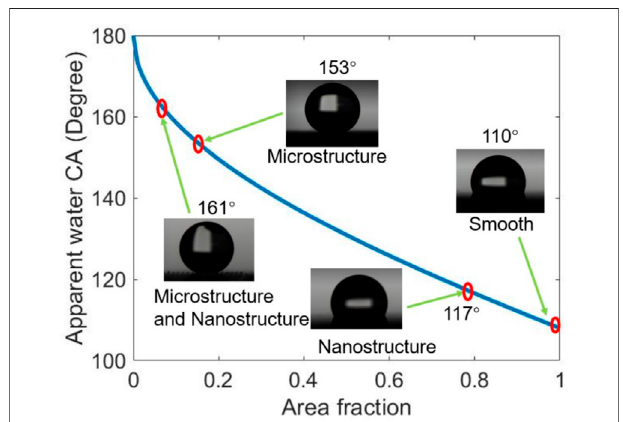
FIGURE6| Theequilibriumwatercontactangleofthevariousstructured surfacescomparedwiththetheoreticalCassiestatecurve.TheapparentCAis the sum of all the contributions of the liquid-solid and liquid-vapor interfaces and is also the contact angle we measured using the goniometer and ImageJ software. And the area fraction is the fraction of the solid in contact with the liquid as described in the Cassie – Baxter equation.